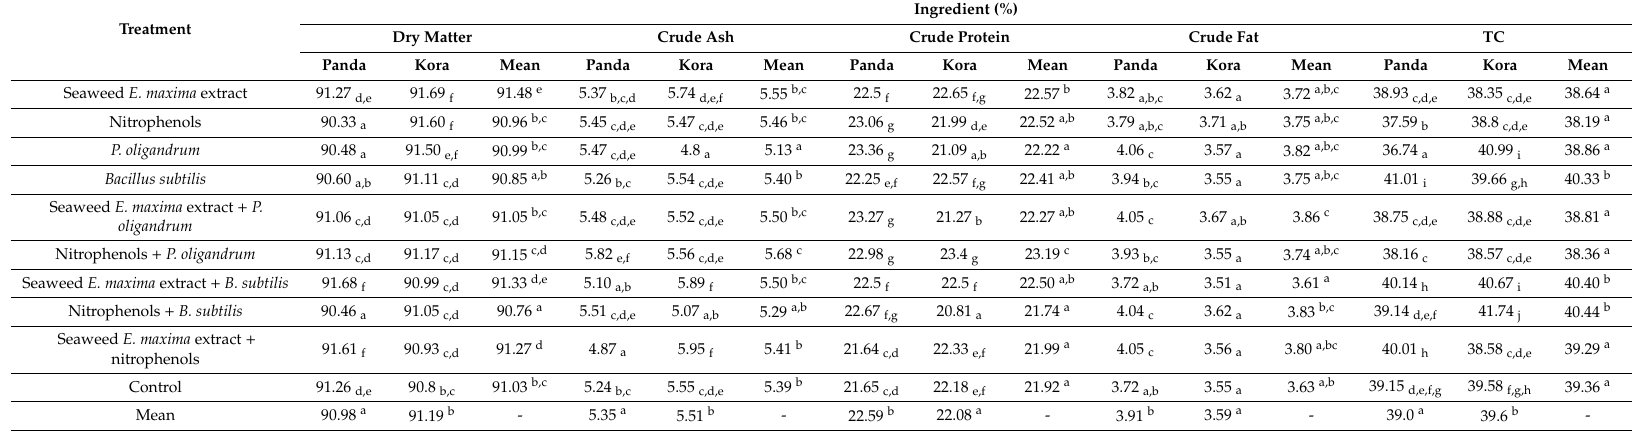
Table 1. E ff ect of cultivar and treatment on the dry matter, crude ash, protein, fat, and total carbohydrates (TC) of buckwheat sprouts. Treatment